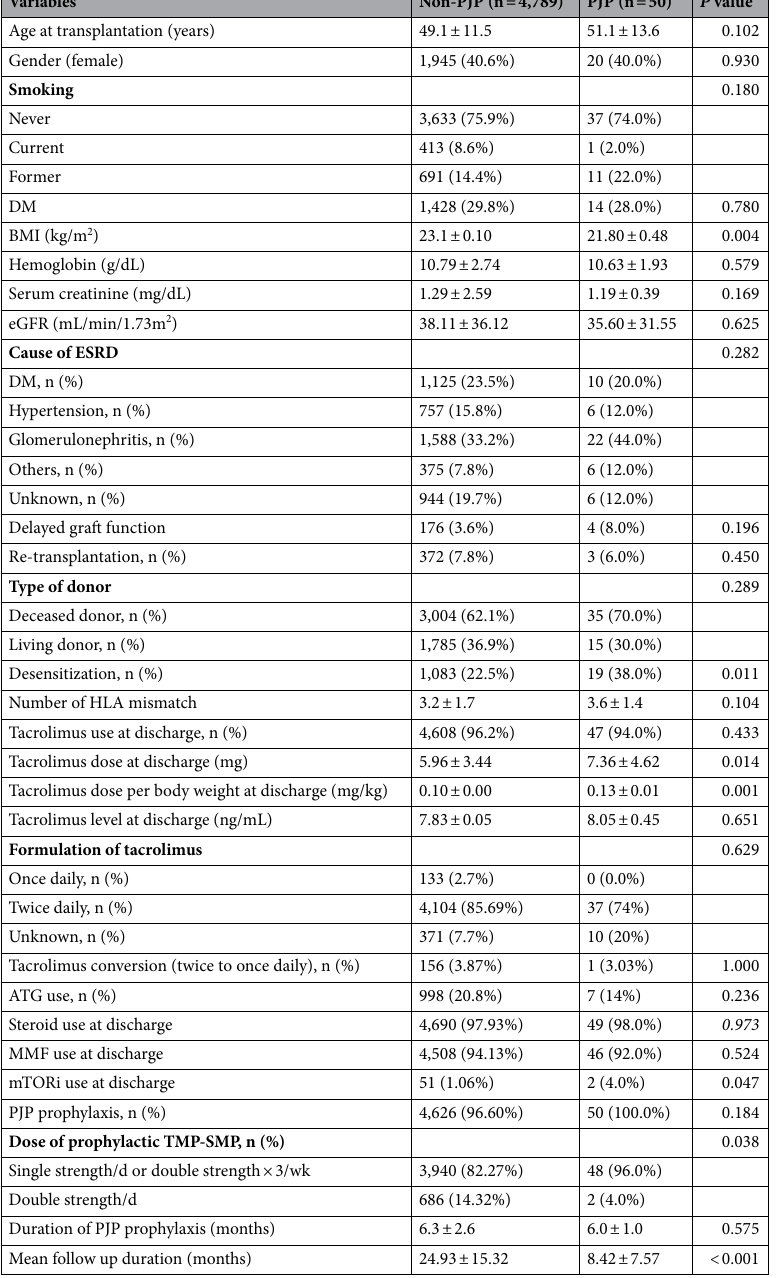
Table 1. Baseline characteristics of kidney transplant patients according to Pneumocystis jirovecii pneumonia. Data are presented as mean ± standard deviation, or n (%). Abbreviations : ATG, anti-thymocyte globulin; BMI, body mass index; d, days; DM, diabetes mellitus; eGFR, estimated glomerular filtration rate; ESRD, end stage renal disease; MMF, mycophenolate mofetil; mTORi, mammalian target of rapamycin inhibitor; N/A, not applicable; PJP, pneumocystis jirovecii pneumonia; TMP-SMX, trimethoprim/sulfamethoxazole; w,